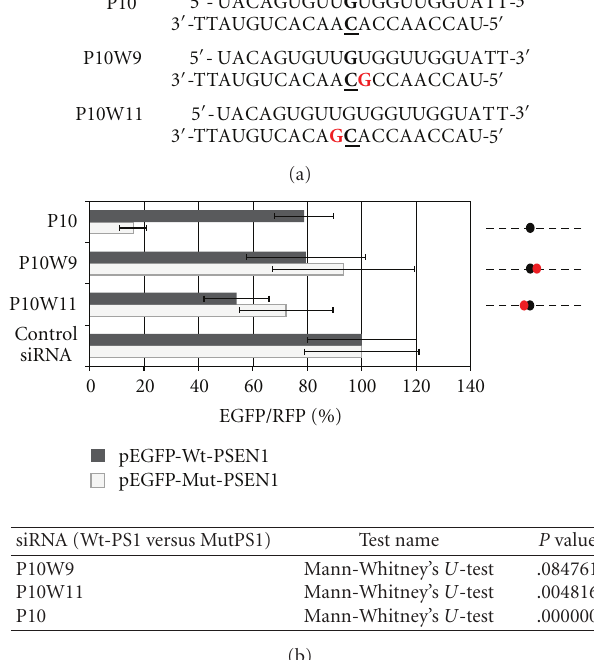
Figure 9: (a) Sequences of the P10W9 and P10W11 siRNAs modified in the central domain at the position 9 or 11; A is replaced by G (in red) to generate the wobble base pair with complementary mRNA strand. (b) Comparison of the florescence levels obtained after co-transfection of HeLa cells with pEGFP-Wt-PSEN1(400) or pEGFP-Mut-PSEN1(400), pDsRed-N1 and indicated siRNAs (P10, P10W9, or P10W11). Dotted lines represent the antisense strands of the used siRNAs. Positions of the C-C mismatch between the guide strand of siRNA and the wild-type PSEN1 mRNA are indicated by the black dots. Red dots represent the sites of the wobble base pairs between the guide strand of siRNA and the wild- or mutated-type of PSEN1 mRNA. The level of the relative EGFP/RFP fluorescence in cells transfected with control nonsilencing siRNA was used as 100%. The results are mean values from three independent experiments. Statistical analysis of di ff erences between two groups of data (Wt- PSEN1 versus Mut-PSEN1) were calculated by the use by the nonparametric Mann-Whitney’s U -test. The di ff erences with P < . 05 were considered as statistically significant.